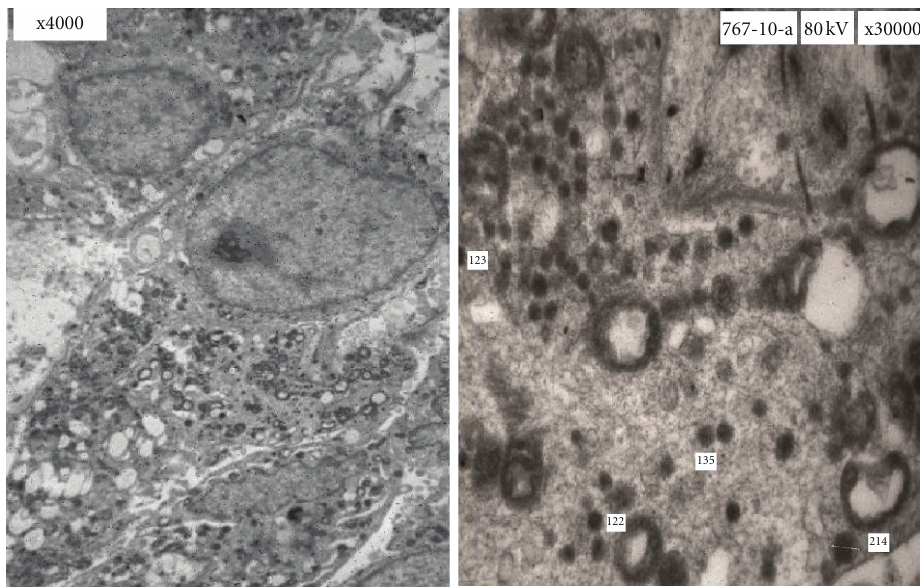
Figure 6: Electron microscopy picture showing multiple granules of varying sizes.